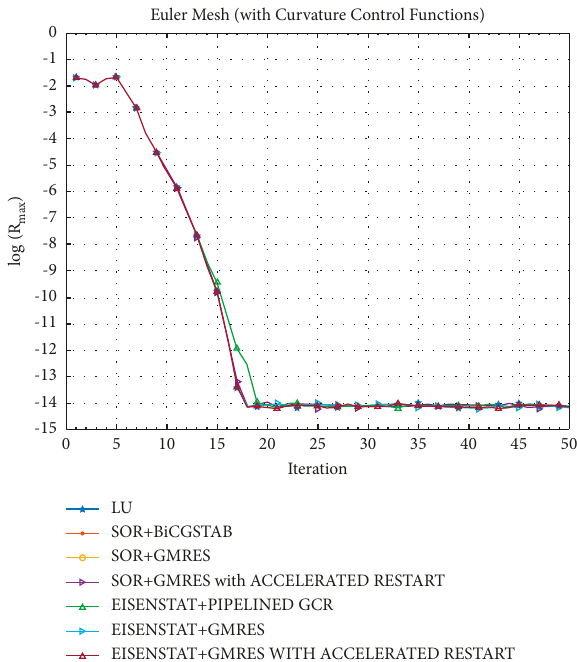
Figure 15: Convergence for the Euler mesh vs. iteration, with curvature functions.